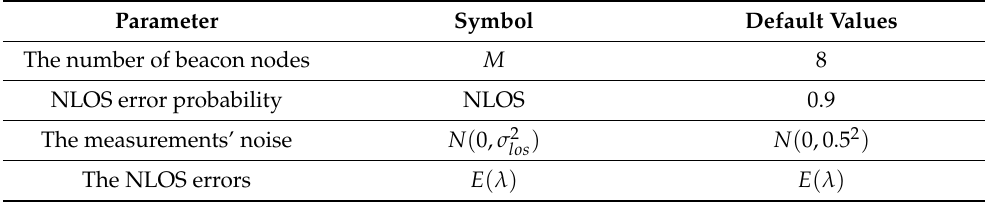
Table 2. Exponential distribution parameter diagram.